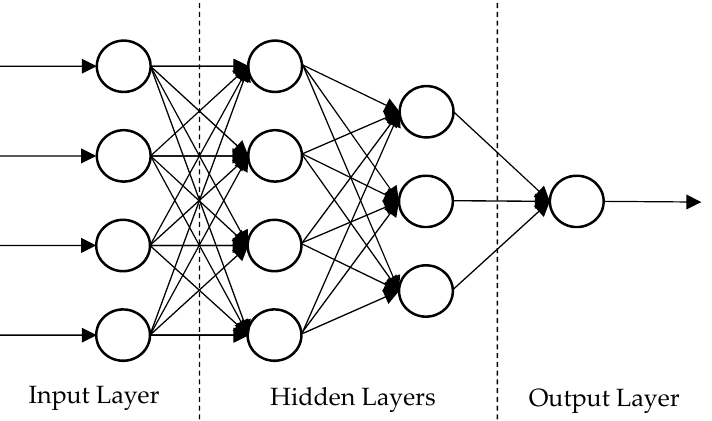
Figure 1. A traditional feedforward neural network (FFNN) model with two hidden layers. Table 6. Activation functions used in ANN